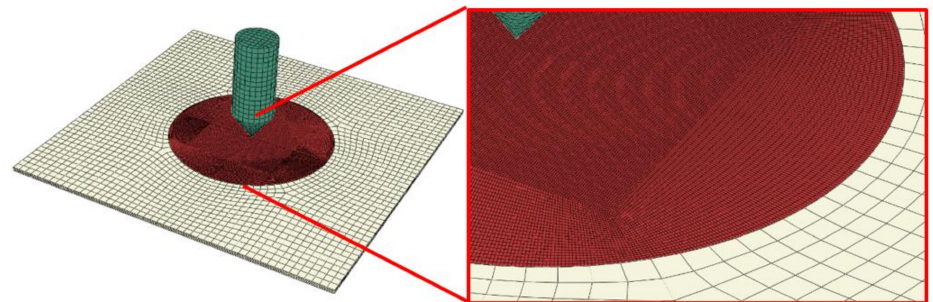
Figure 3. Finite element model used for modelling of the aluminium plate